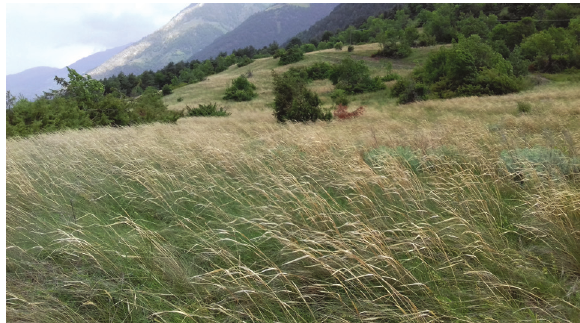
Figure 6. Subassociation stipetosum capillatae (Photo: M. Lübben).